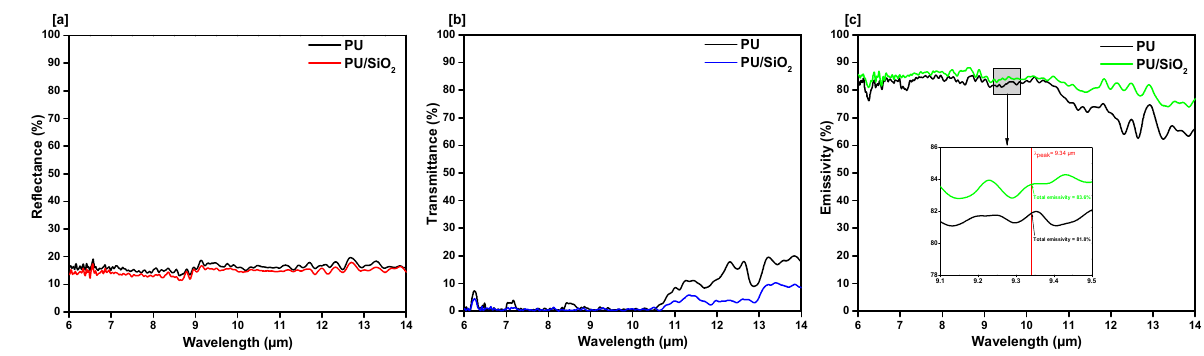
Figure 4. FIR property characterization of silicon dioxide incorporated PU films. FTIR measured ( a ) reflectance, ( b ) trans- mittance, ( c ) emissivity.